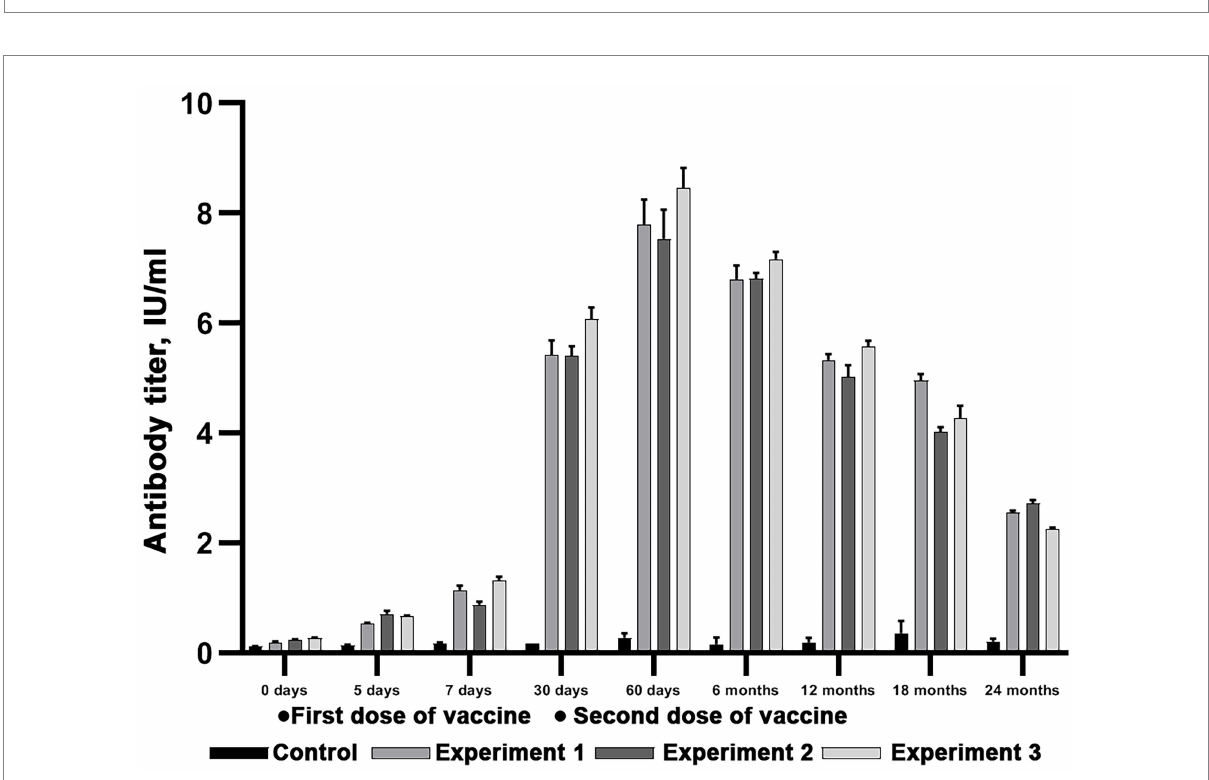
FIGURE 6 Evaluation of virus-neutralizing antibody titers in reindeer blood serum after double immunization with Lyophilized vaccine. Three independent experiments (Experiment 1, Experiment 2 and Experiment 3). In each experiment, six animals were vaccinated in doses equal to 3 ml. Two unvaccinated animals were used as a control group. The standard deviation is illustrated with whisker caps.